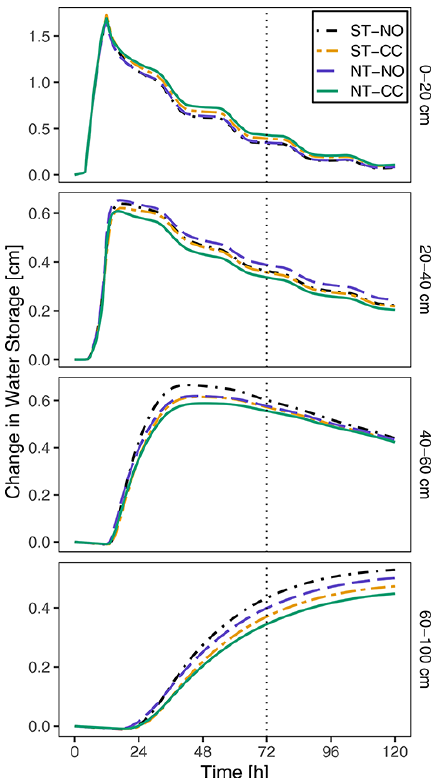
Figure 8. Change in water storage across soil layers (treatment means). The gray, dotted vertical line indicates day 3 after irriga-